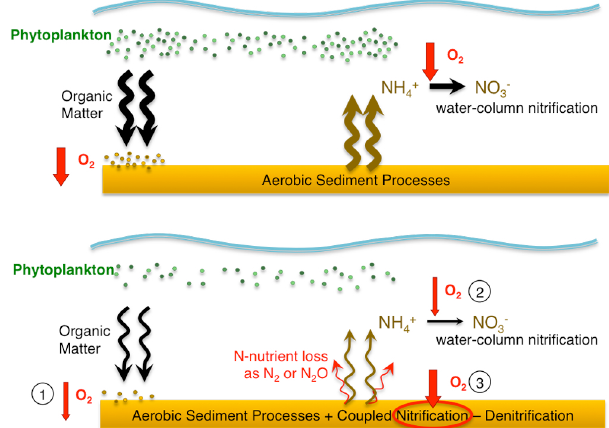
Fig. 1. Schematic of how some ecosystem processes and oxygen consumption are affected by the presence of coupled nitrification- denitrification in the sediments: top) scenario with only aerobic benthic remineralization; bottom) scenario that also considers cou- pled nitrification-denitrification within the sediments. The different width of the arrows between panels represents the change in the magnitude of the fluxes in the two scenarios. Numbers in the bot- tom panel refer to Processes 1, 2, and 3 described in the